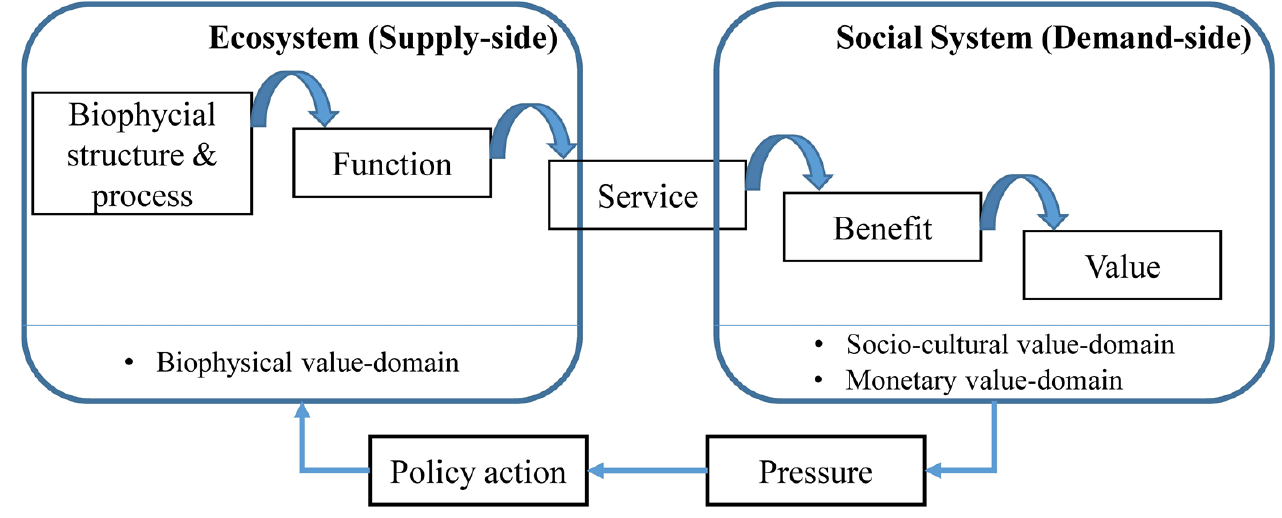
Figure 2. Ecosystem services cascade model.